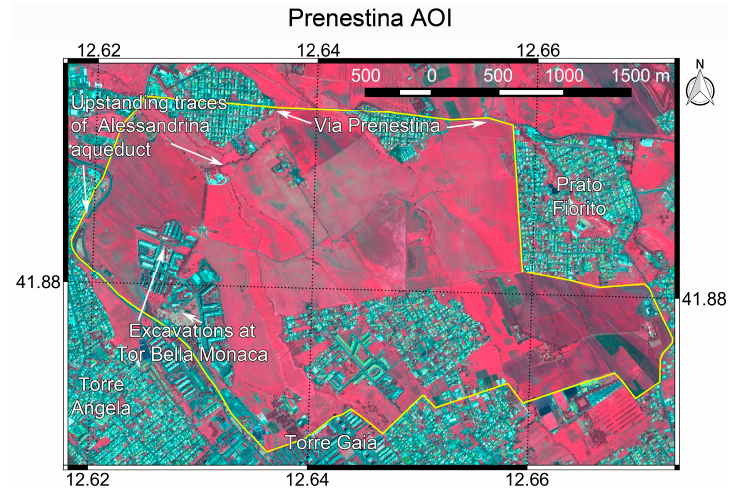
Figure 24. Pleiades image of the Prenestina AOI (shown in yellow polygon), acquired on 20 April 2014, pan-sharpened to 0.5 m spatial resolution and displayed as a false colour composite of NIR, R and G displayed as R, G and B.